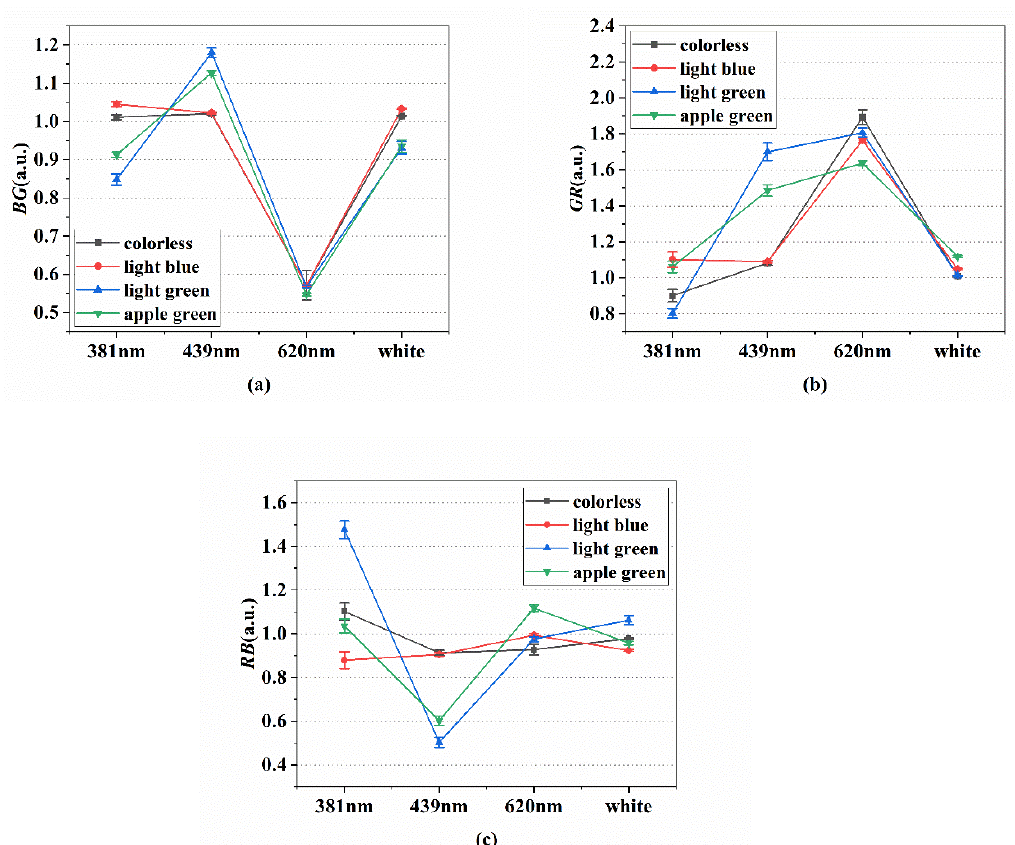
Figure 4. The color parameters BG ( a ), GR ( b ) and RB ( c ) of colorless, light blue, light green and apple green plastic. Table 2. Coefficient of variation of the color parameters BG , GR and RB . Mean of Coefficient of Variation